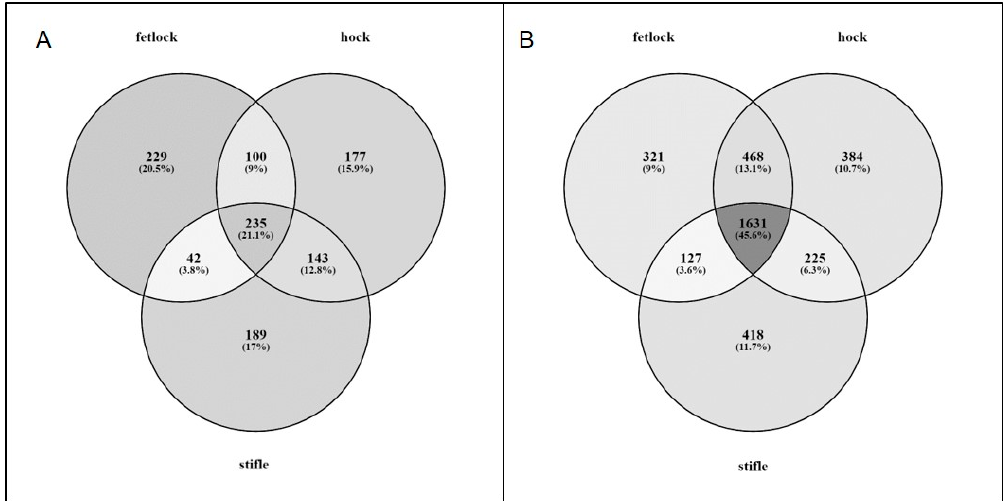
Figure 2. Venn diagrams showing overlap between differentially expressed (DE) genes in the three joint locations in ( A ) articular cartilage (AC) and ( B ) subchondral bone (SCB). Percentages are in reference to the total number of unique DE genes in each tissue (1115 genes in AC, 3574 in SCB).